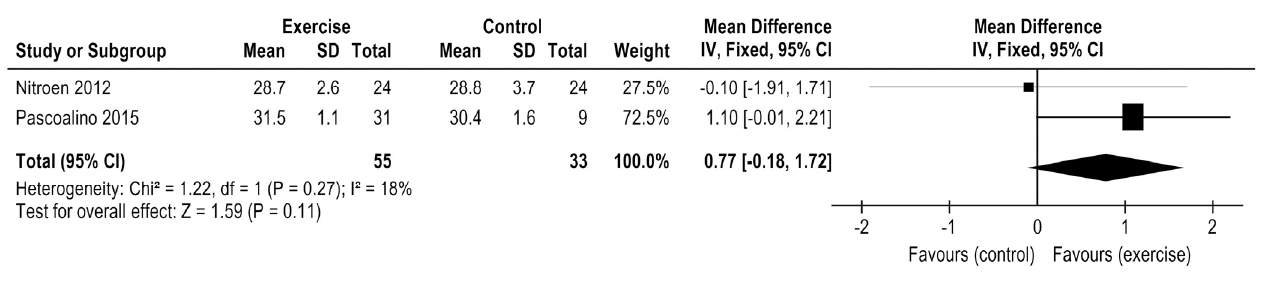
Figure 6. Impact of exercise training on flow-mediated dilation in HTx. 3.6. Exercise Effects on Flow-Mediated Dilation Three studies compared the exercise treatment with control in HTx patients. Exercise training did not demonstrate positive effect on FMD (3 studies, n = 86 patients), MD = 3.48%, 95% CI: − 0.29 to 7.25%, p = 0.07). However, the studies presented a high heterogeneity (I² = 80%)-Figure 6. From those included studies, one study applied MCT- AE [25], one study applied CT [32], and one HIIT [26]. Only HIIT [28] presented an expressive improvement in FMD. However, a subgroup analysis was not possible due to the small number of studies in each exercise modality. Nytroen 2019 compared HIIT vs moderate continuous training and did not indicated differences for this parameter between modalities ( n = 78), MD = − 1.5 ( − 4 to 0.9), p = 0.208 [30]. 3.7. Exercise Effects on Muscle Strength Six studies analyzed the exercise impact on muscle strength, but two were not included in the metanalysis forest plots due to different muscle strength assessments (Isokinetic and isotonic evaluations). Two studies evaluated the maximum repetition test (1RM) and two evaluated the sit-to-stand test. Isolated resistance training (RT) was associated with a significant improvement in the 1RM for both chest press and leg extension movements, MD = 35.50 Kg, 95% CI: 19.42 to 51.59, I² = 70, p < 0.0001) (Figure 7A) while the other two studies involving combined training showed increases on the sit- to-stand test, MD: 5.54, 95% CI 3.07 to 8.01; I² = 0% (Figure 7B). Isokinetic and isotonic evaluations not included in the metanalysis forest plots, also suggested an increase in muscle strength after CT and AT, respectively [27,34].